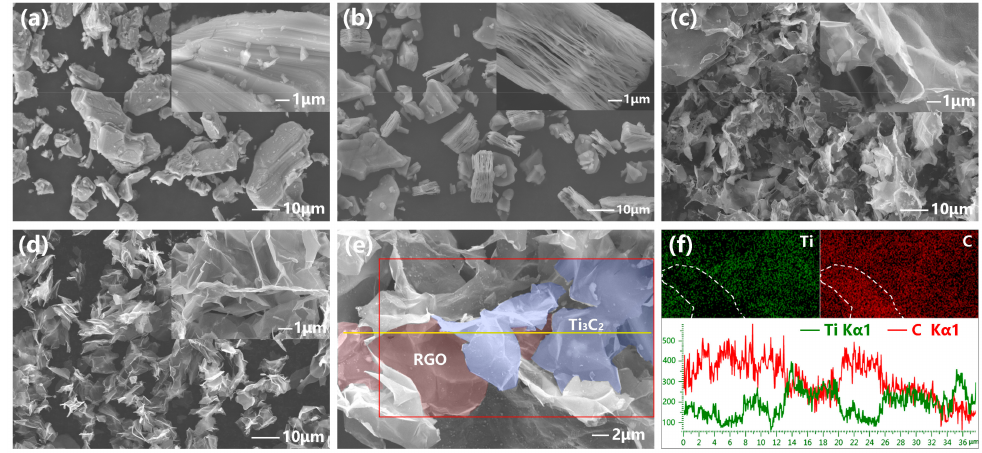
Figure 2. Scanning electron microscopy (SEM) image of Ti 3 AlC 2 ( a ), Ti 3 C 2 T x ( b ), GO/Ti 3 C 2 T x ( c ), and RGO/Ti 3 C 2 T x ( d ). Element area profile and linear scanning of RGO/Ti 3 C 2 T x ( e , f ).